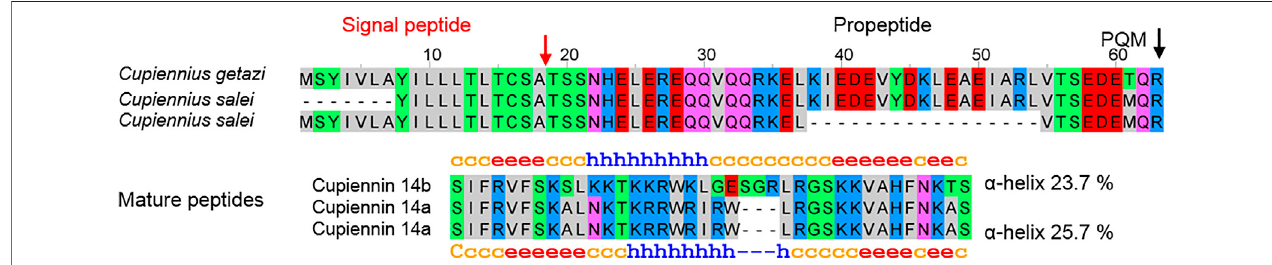
TABLE 2 | Overview of the percentage of LPs in the transcriptomes of different spiders. Spider family